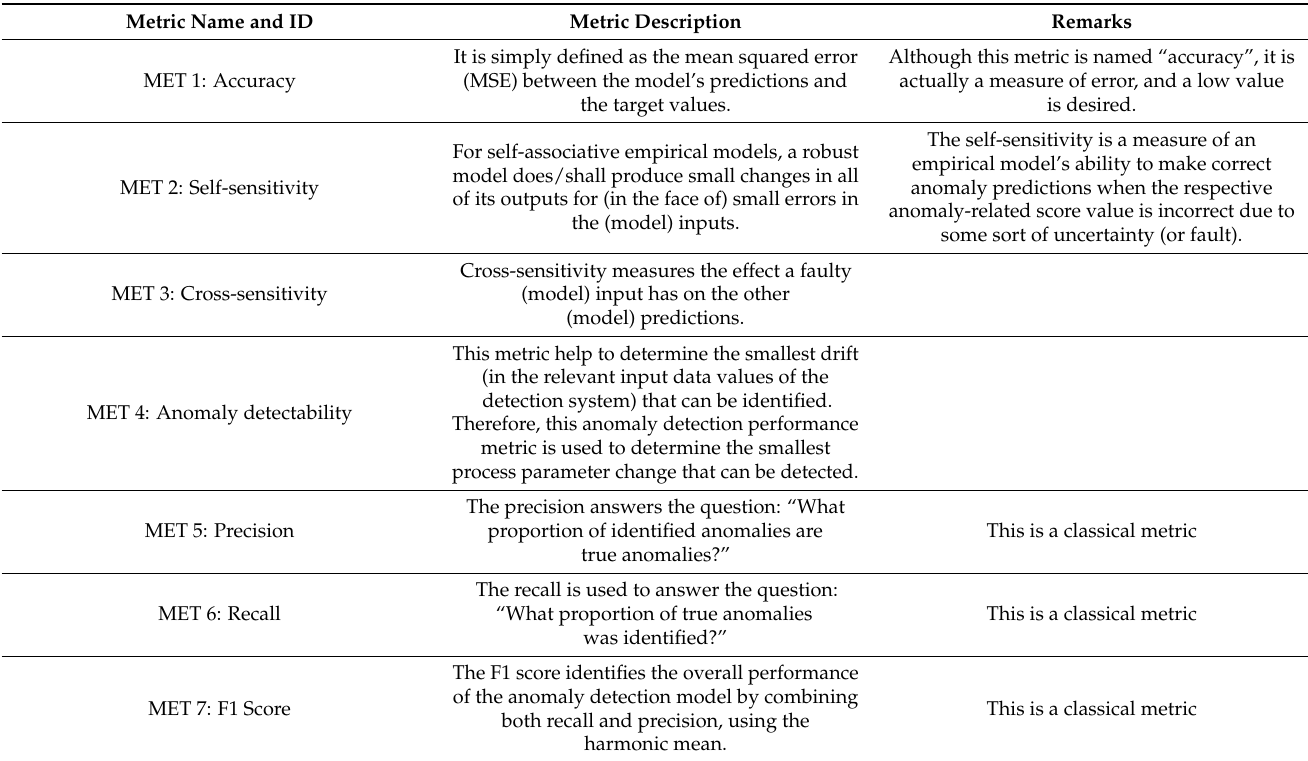
Table 5. A selected collection, just for illustrative) of performance evaluation metrics (METs), which can be relevant for a comprehensive verification and validation of an anomaly detection- and-prediction system developed for the monitoring of a human in